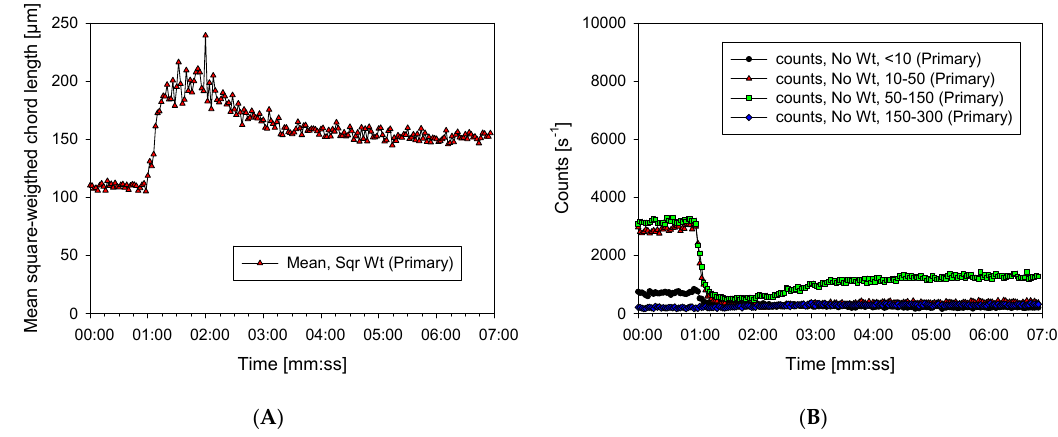
Figure 10. ( A ) Mean square chord length and ( B ) counts evolution of suspension: 200 ppm of guar gum added after 1 min (MIBC 20 ppm, PAX 75 ppm).